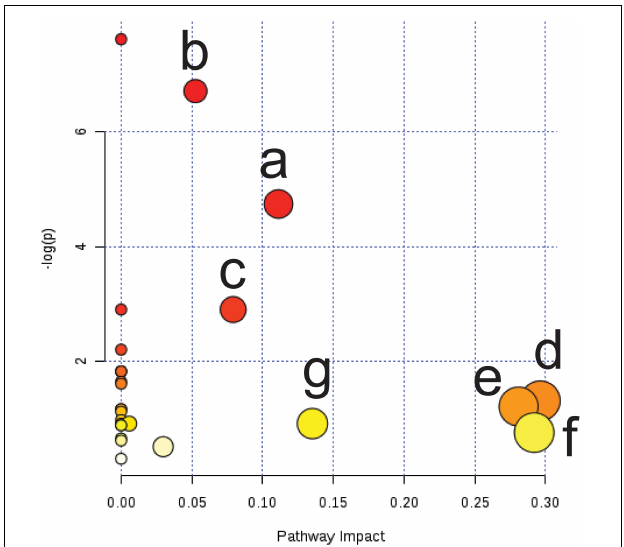
FIGURE 7 | Summary of pathway analysis of serum and urine samples from cold asthma rats. (a) Starch and sucrose metabolism; (b) Galactose metabolism; (c) Tricarboxylic acid cycle; (d) Glyoxylate and dicarboxylate; (e) Glycerol phospholipid metabolism; (f) Glycine, serine, and threonine metabolism; (g) Inositol phosphate